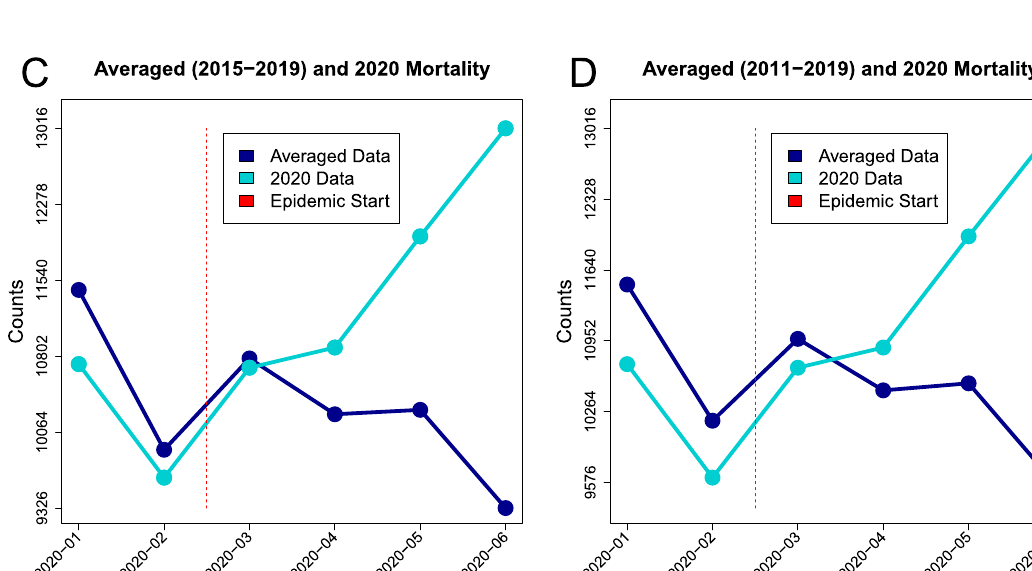
Figure 3. The visual summaries of non-parametric mortality P -scores presented for five (panel A ) and nine (panel B ) years where orange bars represent the epidemic period. The corresponding averaged data (dark blue) based on the previous five (panel C ) and nine (panel D ) years are presented along with the reported data for 2020 (cyan). Vertical red bars indicate the epidemic start